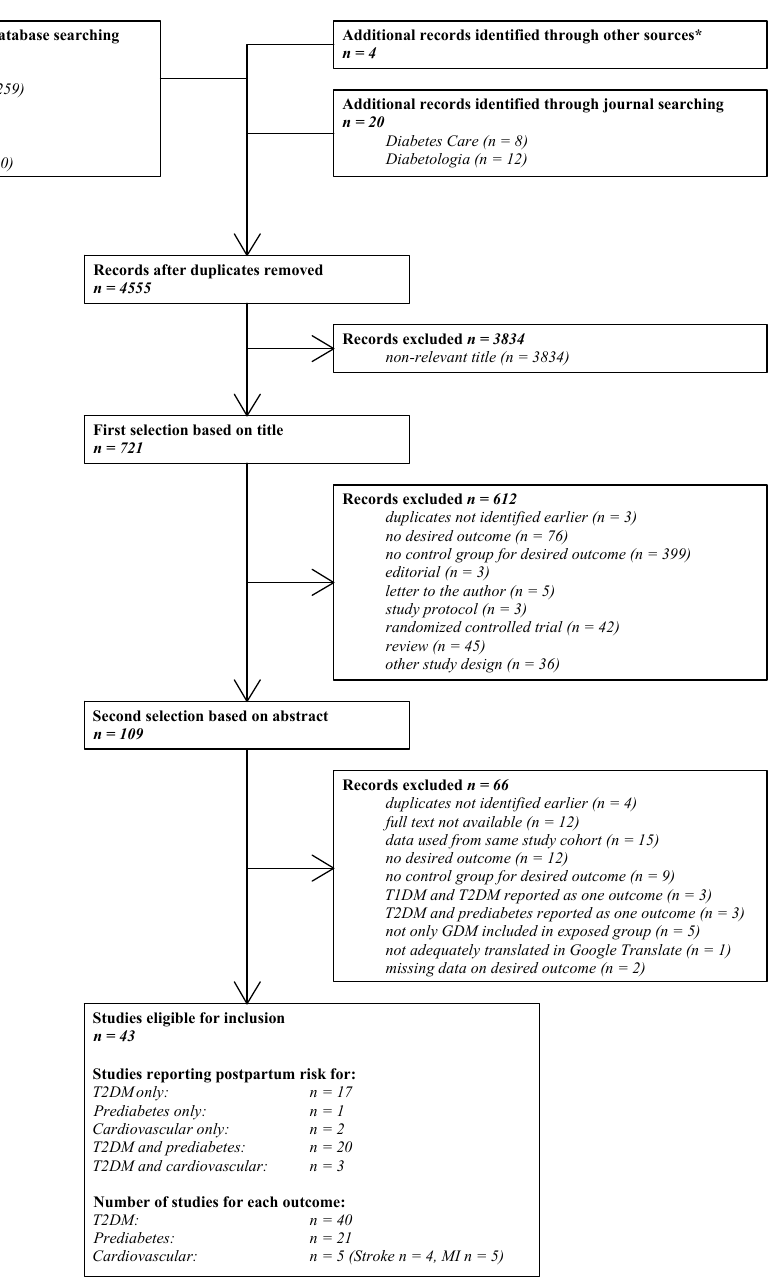
Figure 1. The literature search and selection process. N: the number of studies; LILACS: Latin American and Caribbean Health Sciences Literature; T1DM: type 1 diabetes mellitus; T2DM: type 2 diabetes mellitus; GDM: gestational diabetes mellitus; MI: myocardial infarction. * Retrieved from the systematic review of Song et al. [8].